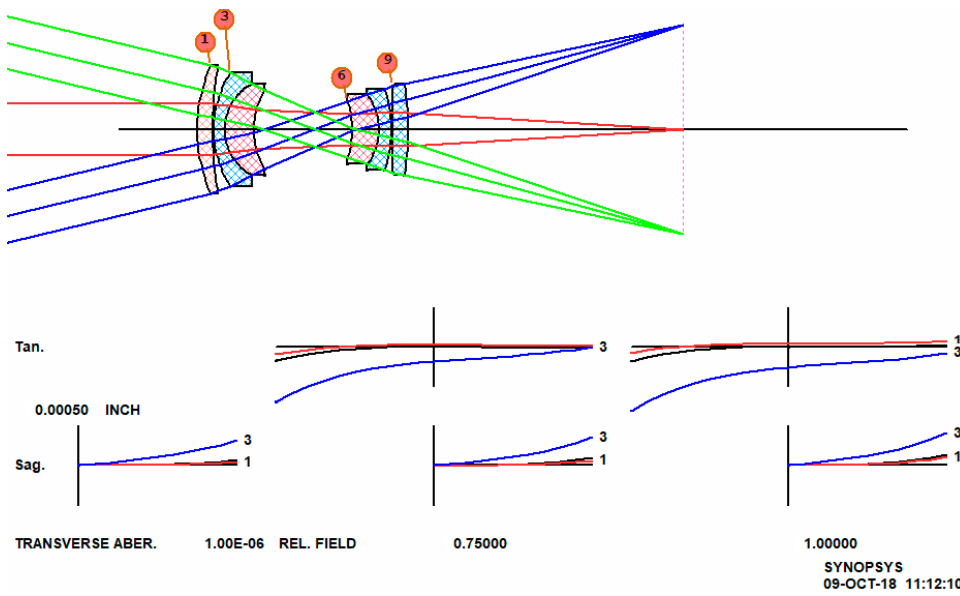
Figure 5. Design 3-87 from Cox.